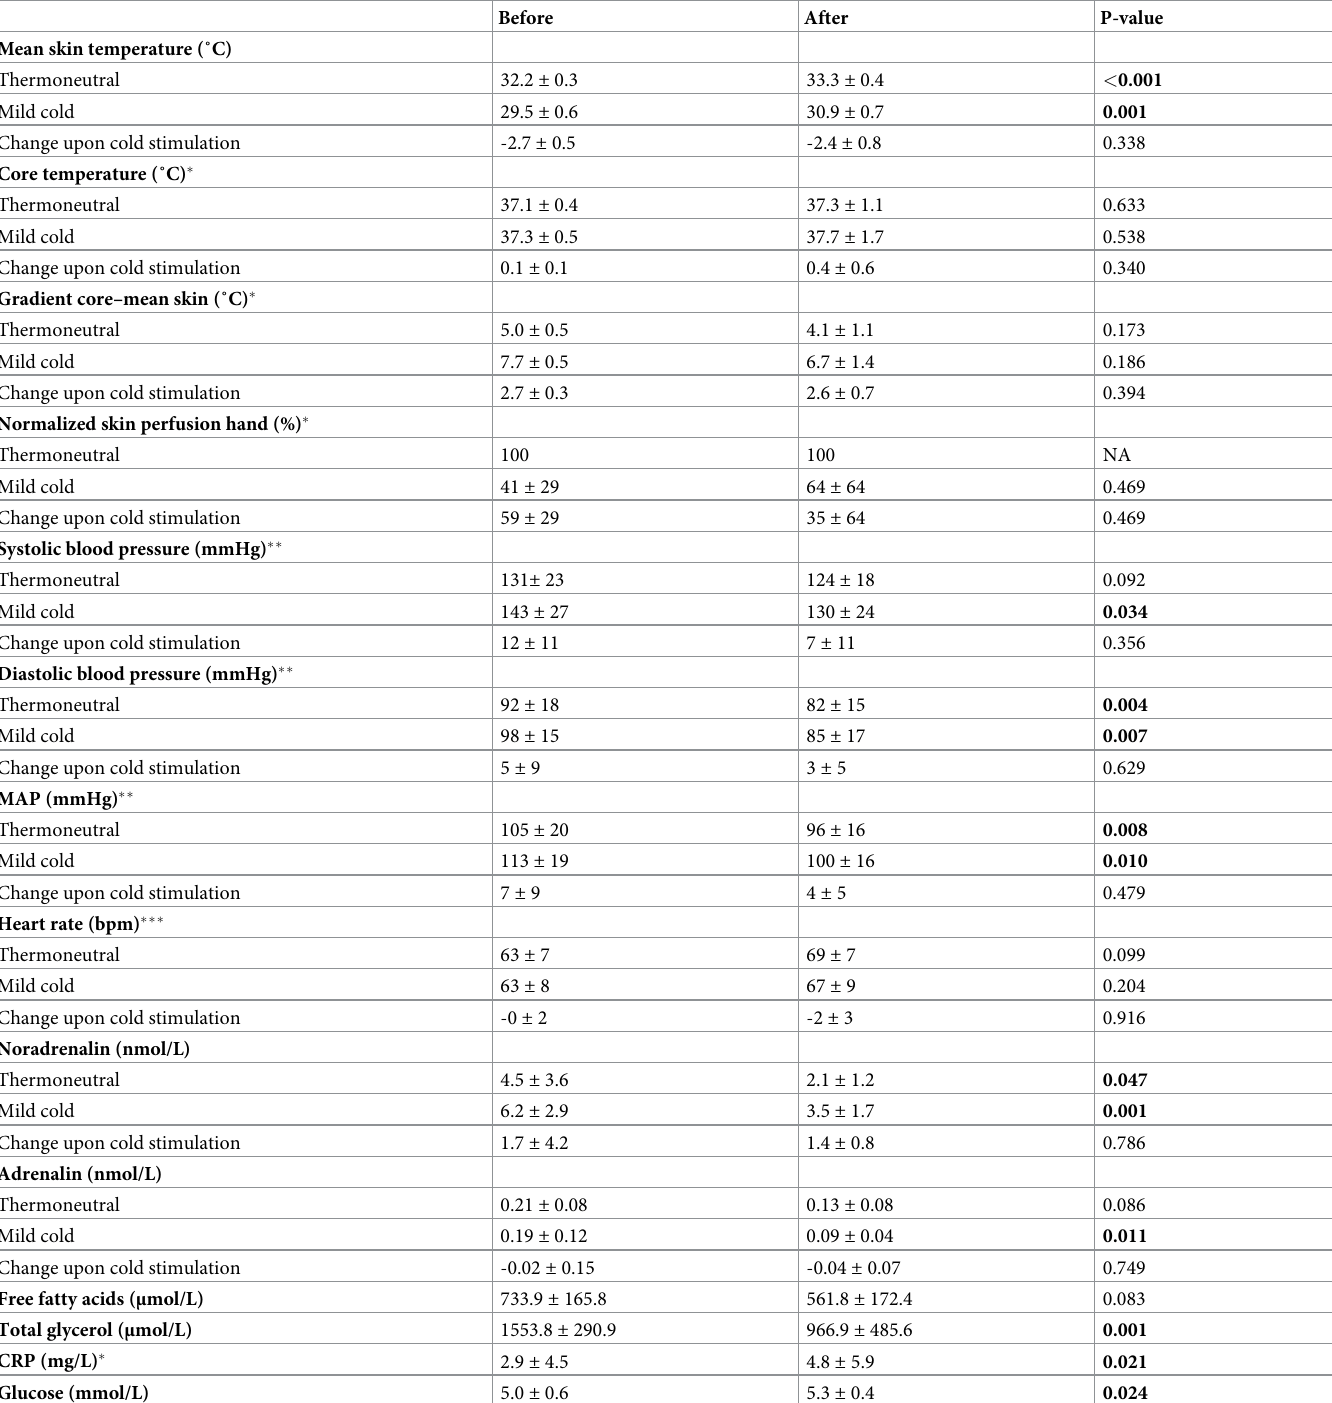
Table 2. Body temperature, skin perfusion, blood pressure and catecholamines under thermoneutral conditions and during mild cold exposure, before and after levothyroxine substitution. Blood values under thermoneutral conditions before and after levothyroxine substitution. Before After